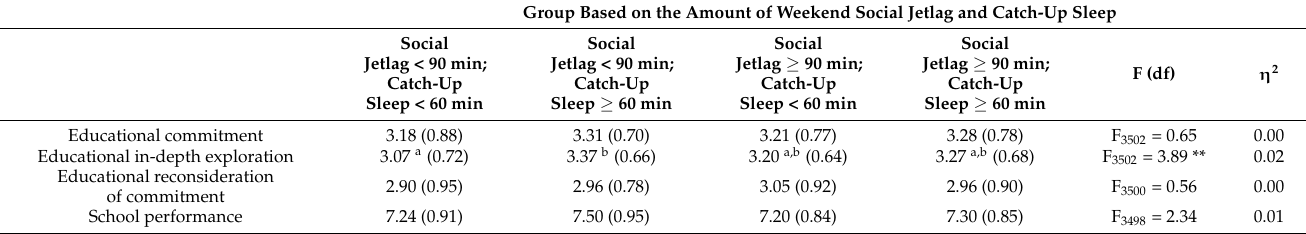
Table 3. Differences in school experience according to the sleep-recovery strategies. Group Based on the Amount of Weekend Social Jetlag and Catch-Up Sleep Social Social Jetlag < 90 min; Jetlag < 90 min; Catch-Up Sleep < 60 min